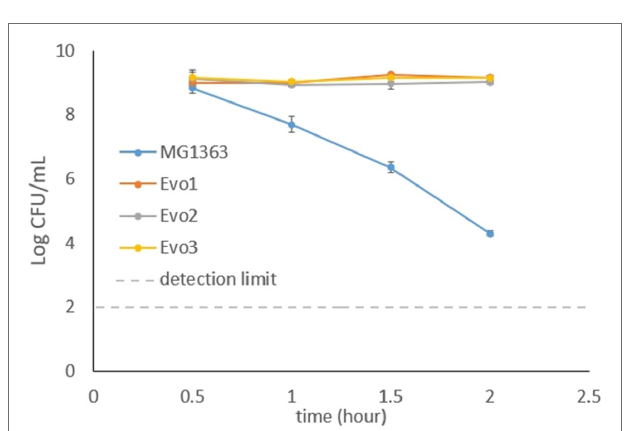
FIGURE 4 | Oxygen consumption rate of strain MG1363 and evolved strains under aerobic and respiration-permissive conditions. Cells for this test were obtained from overnight cultures in GM17 media at 30 ° C under anaerobic condition, and in addition 2 μ g/ml heme was supplemented to the culture for obtaining cells used for respiration-permissive (RES) condition oxygen consumption test. PBS-washed cells were suspended in air-saturated PBS (OD standardized all to 2) for oxygen consumption test at room temperature. Reaction was initiated by adding 1% glucose. Data from four independent experiments, error bars represent SEM. * Indicates significant difference compared to MG1363 under the same condition ( p ≤ 0.05).